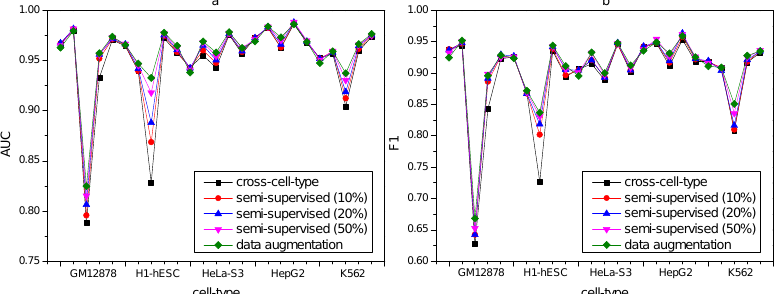
Figure 5. ( a , b ) denote AUC performance and F1 score comparison between data augmentation, semi-supervised, and cross-cell-type prediction,